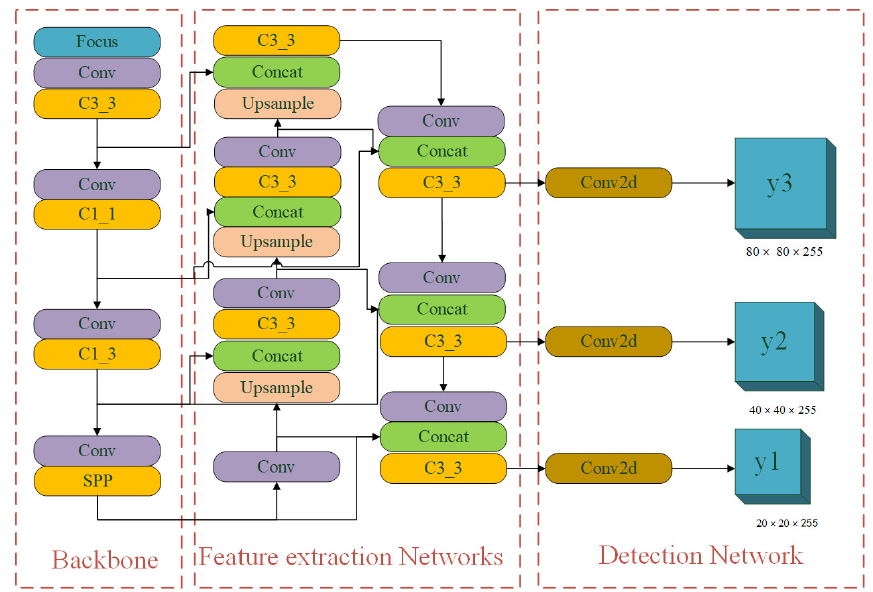
Figure 1. BV-YOLOv5S network structure. It is mainly composed of three parts: backbone networks, feature extraction networks, and detection networks.